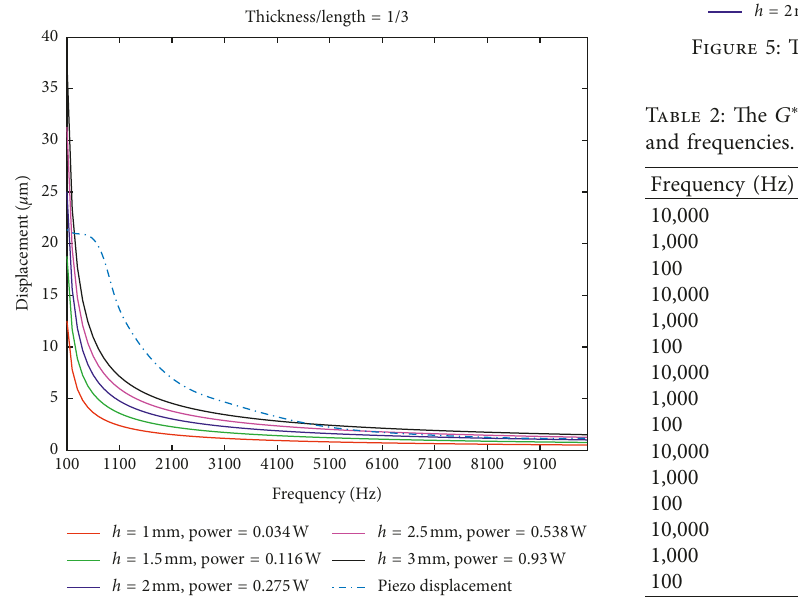
Figure 4: The relation between the required displacement and the ability of the piezoelectric actuator displacement at different frequencies.